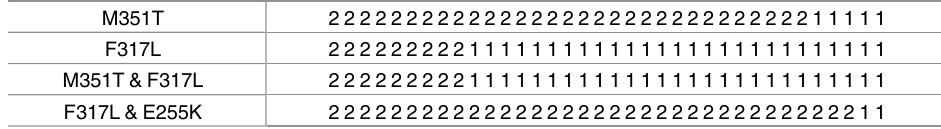
Table 6. The optimal treatment schedules with two mutants.